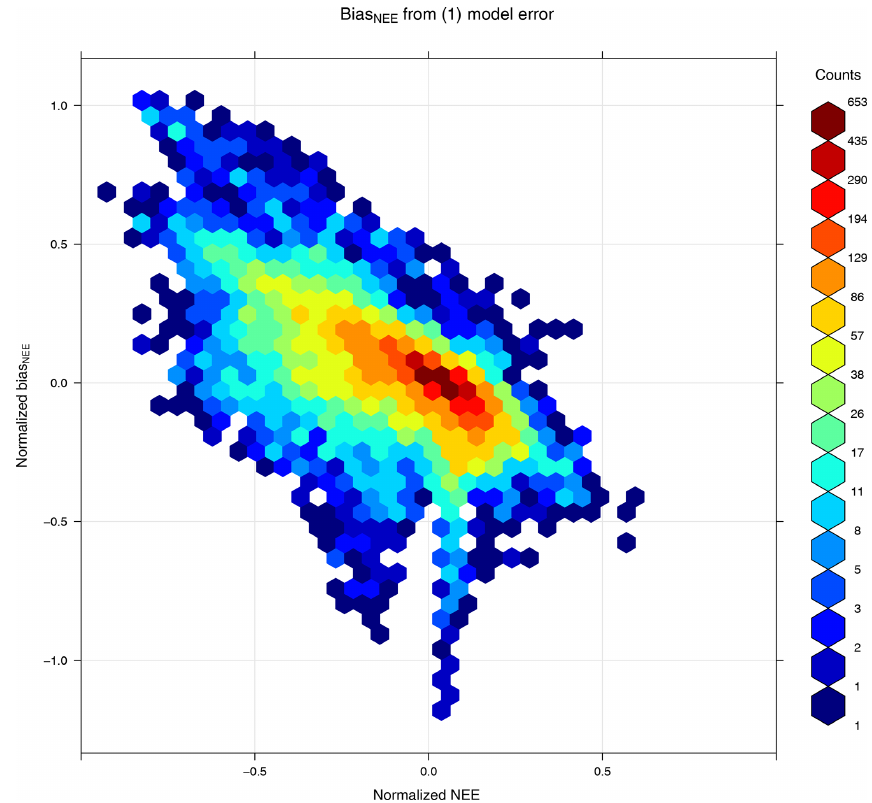
Figure 7. The Bias NEE distribution of the VPRM model error.